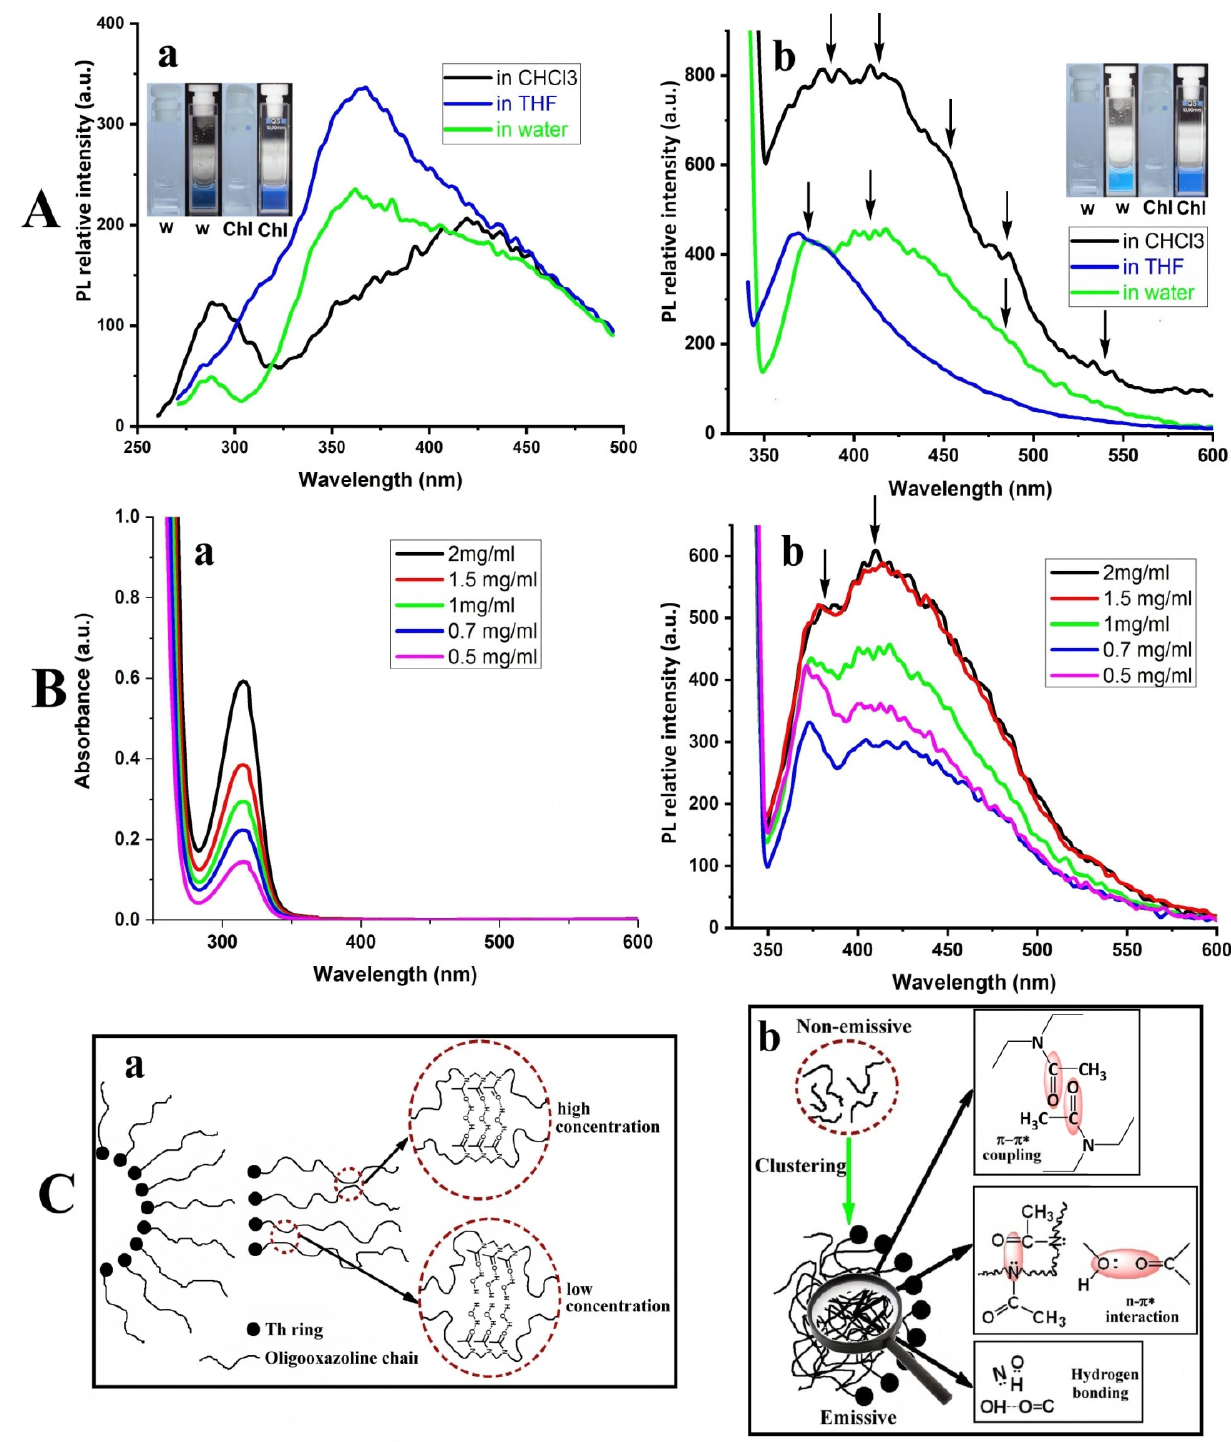
Figure 3. ( A )Fluorescence spectra of Th-OMeOx in different solvents at λ ex = 260 nm ( a ) and at λ ex = 330 nm ( b ); ( B )UV–vis spectra ( a ) and fluorescence spectra ( b ) of Th-OMeOx registered in water (c = 1mg/mL) at different concentrations, using λ ex =330 nm for fluorescence; ( C ) schematic representation of presumptive behavior of OMeOx chains in SA micelles formed in water at low and high concentrations ( a ) and in SA micelles in Chl ( b ); the inset in ( A ) shows photos of dispersion in water (w) and in Chl in daylight and under UV light (256 nm ( Aa ) and 365 nm ( Ab )). DLS measurements (Table 1 and Figure S4) prove that Th-OMeOx , by simple “di- rect dissolution”, forms self-assembled supramolecular structures in all investigated